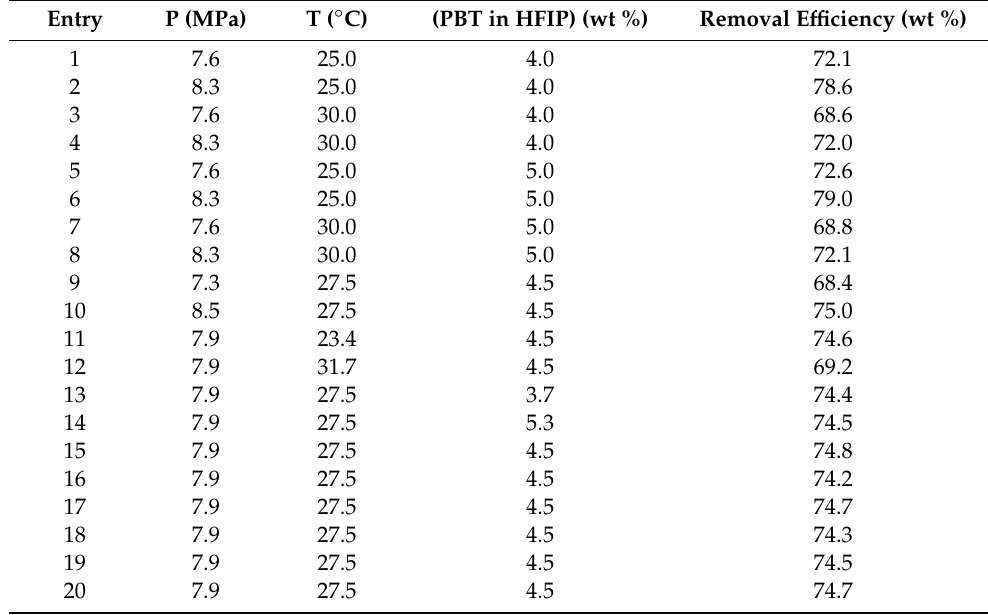
Table 2. Removal e ffi ciency of the cyclic trimer from PBT by compressed CO 2 antisolvent technique.